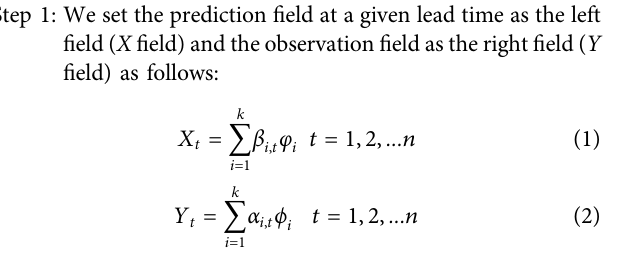
Frontiers in Earth Science |